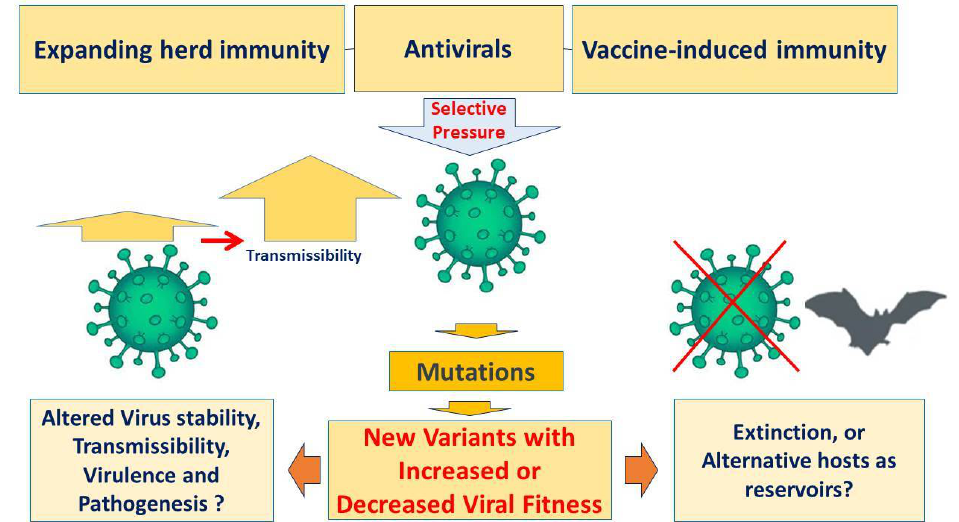
Figure 3. Non-robust antivirals can drive SARS-CoV-2 to evolution and the emergence of new variants by exerting selective pressure on the virus. Increased transmissibility, risk of jumping to other species, and resistance against antibodies and drugs can be associated with the emergence of new variants [11].